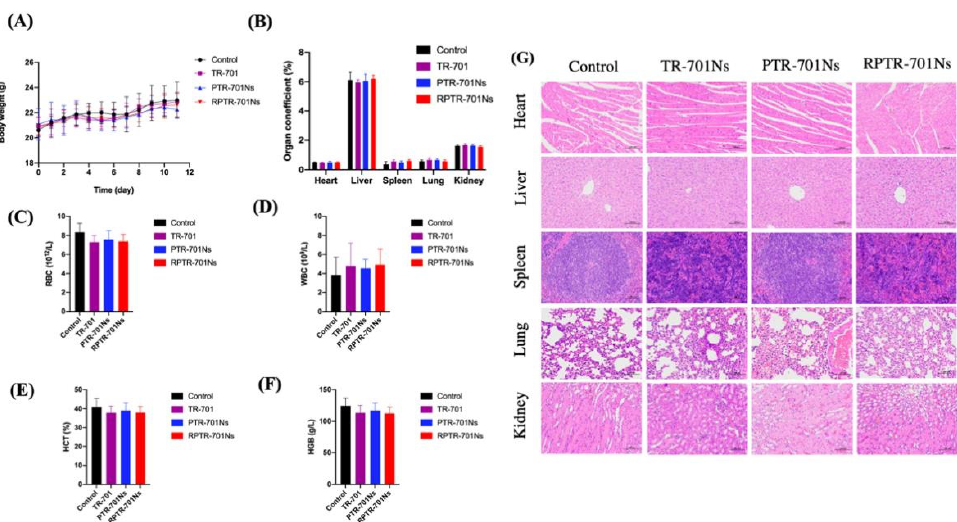
Figure 11. In vivo safety of the treatment. ( A ) Body weight changes in different groups during the treatment. ( B ) Organ coefficients. ( C ) RBCs, ( D ) WBCs, ( E ) HCT, ( F ) HGB, ( G) H&E staining of main organs. Data were presented as mean SD ( n = 6).